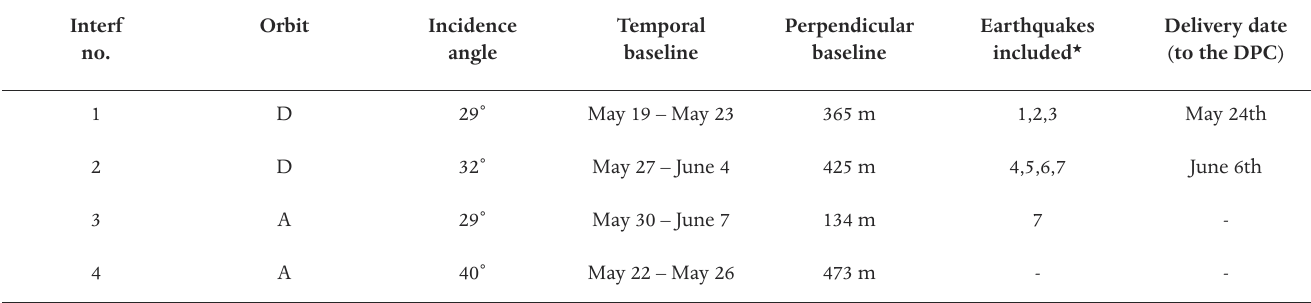
Table 1. COSMO-Skymed interferograms, as detailed in the text. *Earthquakes included in each time period are referred to in Figure